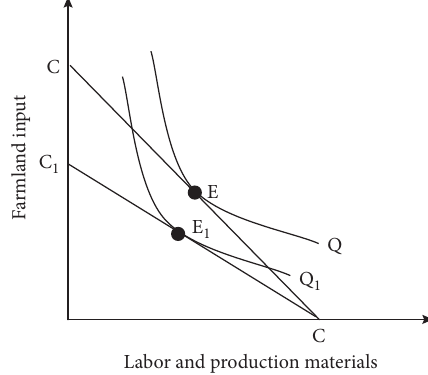
Figure 4: The impact of the increase in rent on grain